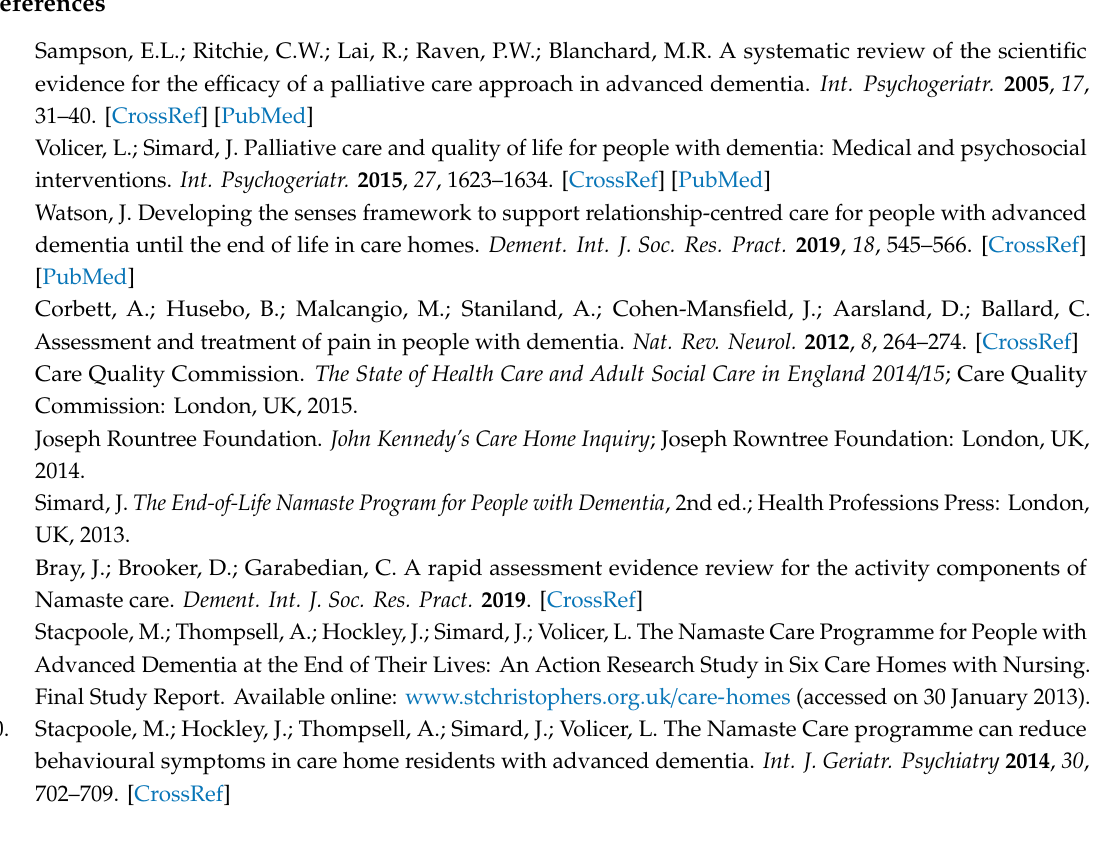
Table S1: Guidance, Table S2: NSQ, Table S3: TIDieR